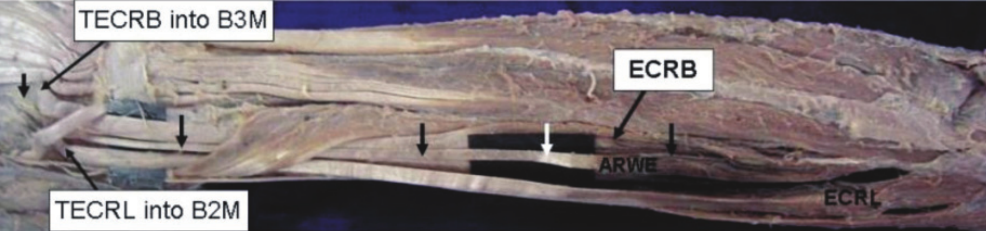
Figure 3a - Extensor compartment of the right forearm and hand region. TECRB into B3M, tendon of extensor carpi radialis brevis inserted into the base of the third metacarpal bone; TECRL into B2M, tendon of extensor carpi radialis longus inserted into the base of the second metacarpal bone. Note that the downward arrows indicate the course of the additional muscle.